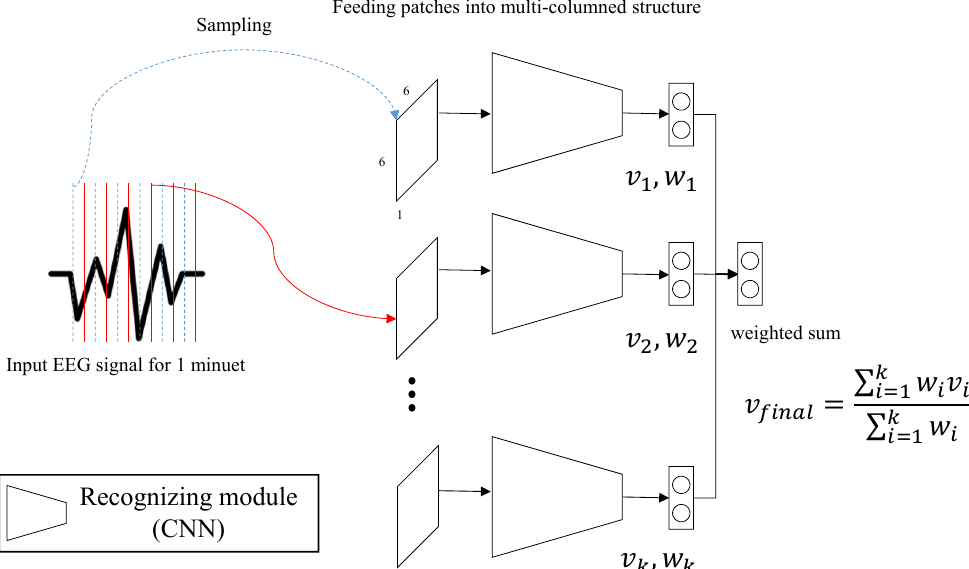
Figure 3. The multi-column structure of our model. The final decision is produced from a weighted sum of the decisions from the individual modules.